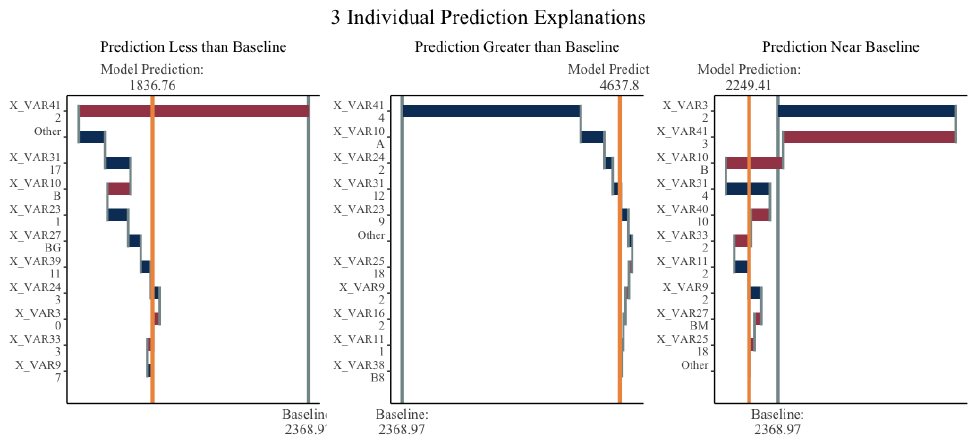
Figure 24. An explanation of three different individual predictions on the COLL test dataset using the mSHAP values. The yellow line shows the model prediction and the grey line is the average model prediction across the training set. Colored bars represent the impact from the 10 most important